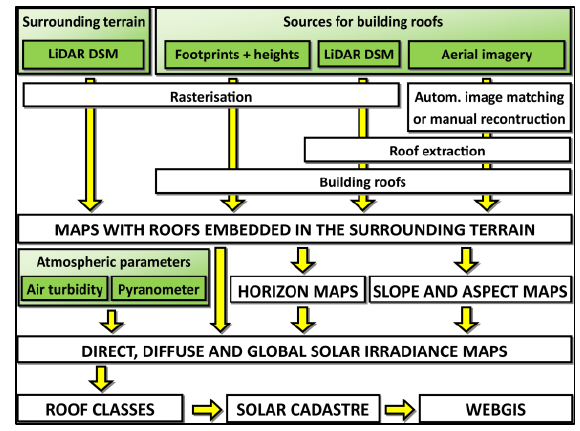
Figure 3: The pipeline of the 3DSolarWeb project for the precise estimation of the photovoltaic (PV) potential and its spatial distribution in (alpine) urban areas.